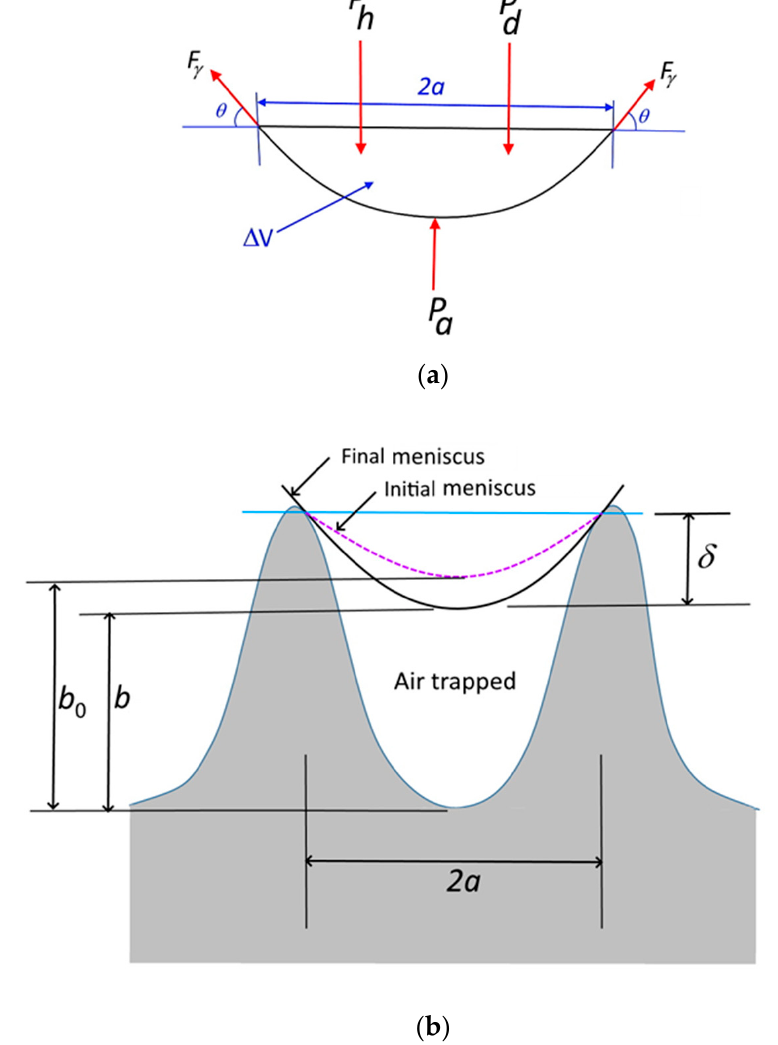
Figure A1. A schematic view of the nanostructured surface: ( a ) forces acting at the droplet meniscus across texture gap and ( b ) droplet meniscus across texture gap before and after the impact of the droplet.